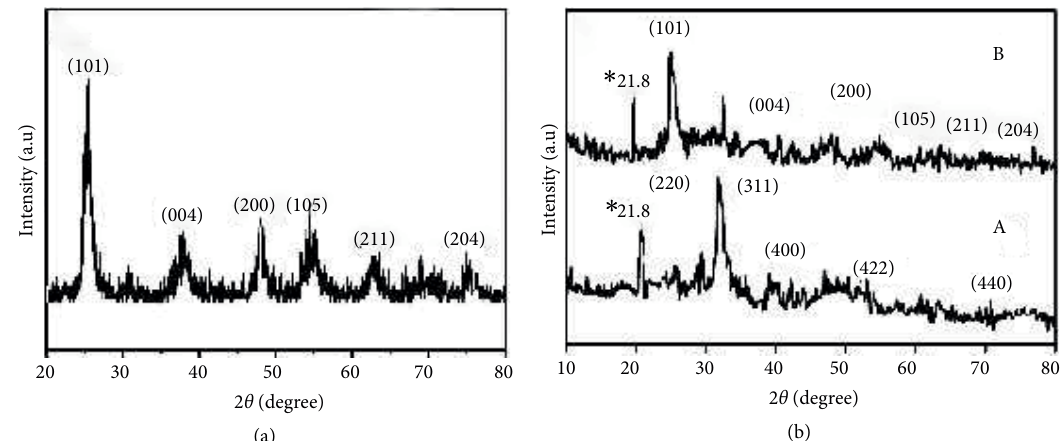
Figure 2: XRD patterns of synthesized nanomaterials: (a) TiO